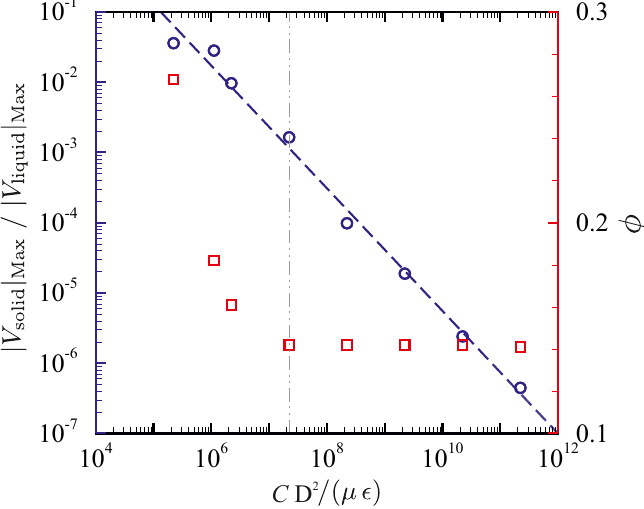
Figure 6. The ratio of the maximum velocity magnitude in solid regions to that in liquid regions ( | (cid:126) V solid | Max / | (cid:126) V liquid | Max , blue circles) and the predicted liquid fractions φ (red squares) for various (cid:0) (cid:1) C D 2 / ( µ(cid:101) ) values of the sink term